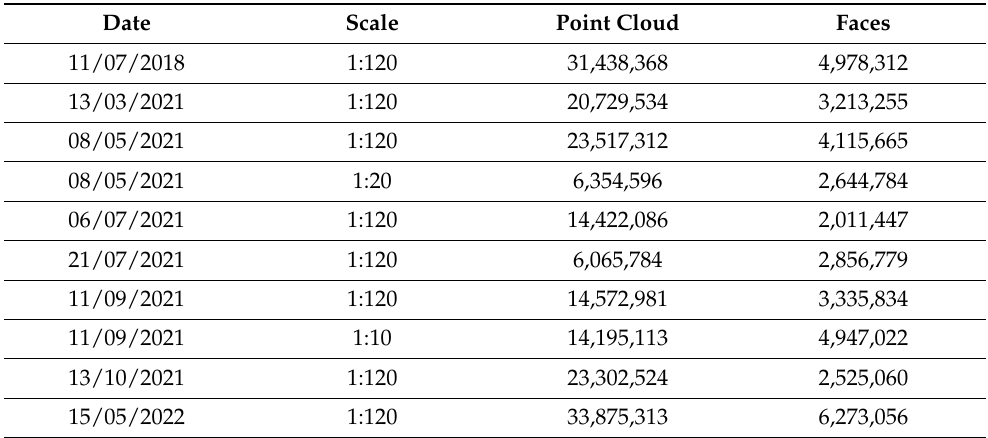
Table 5. Number of points of 3D point clouds and number of surfaces of 3D meshes for each recording date and the corresponding cartographic